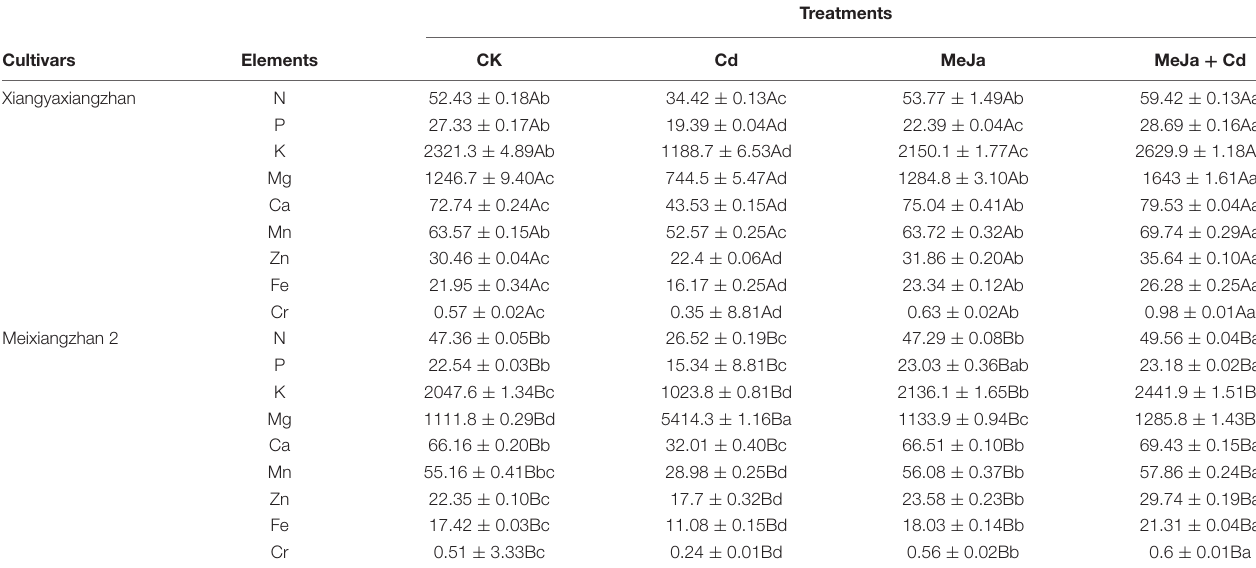
The values are representative of three replicated means per treatment ± SE. Different letters indicate significant differences between cultivars and treatments at p < 0.05, LSD. CK; control (normal conditions); Cd:100 mg Cd kg − 1 of soil, MeJa: exogenous application of MeJa at 20 mM, and Cd + MeJa: 100 mg Cd kg − 1 of soil + exogenous MeJa application at 20 mM. TABLE 4 | The effects of exogenous MeJa application on grain mineral elements (mg/kg) in two fragrant rice cultivars under Cd stress.